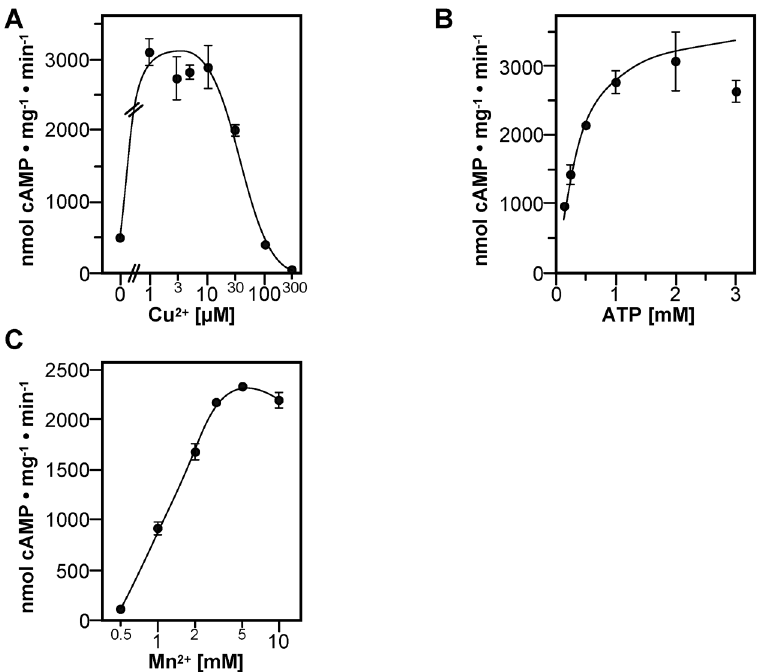
Fig 4. Stimulation of full-length MpAC 1-233 by Cu 2+ assayed with Mn 2+ as a cofactor. (A) Effect of Cu 2+ . Reactions contained 0.4 μ M MpAC 1-233 , 5 mM Mn 2+ and 1 mM ATP. (B) Substrate kinetics measured with 5 mM Mn 2+ as a cofactor and 10 μ M Cu 2+ . (C) Mn 2+ -dependance assayed at 1 mM ATP and 10 μ M Cu 2+